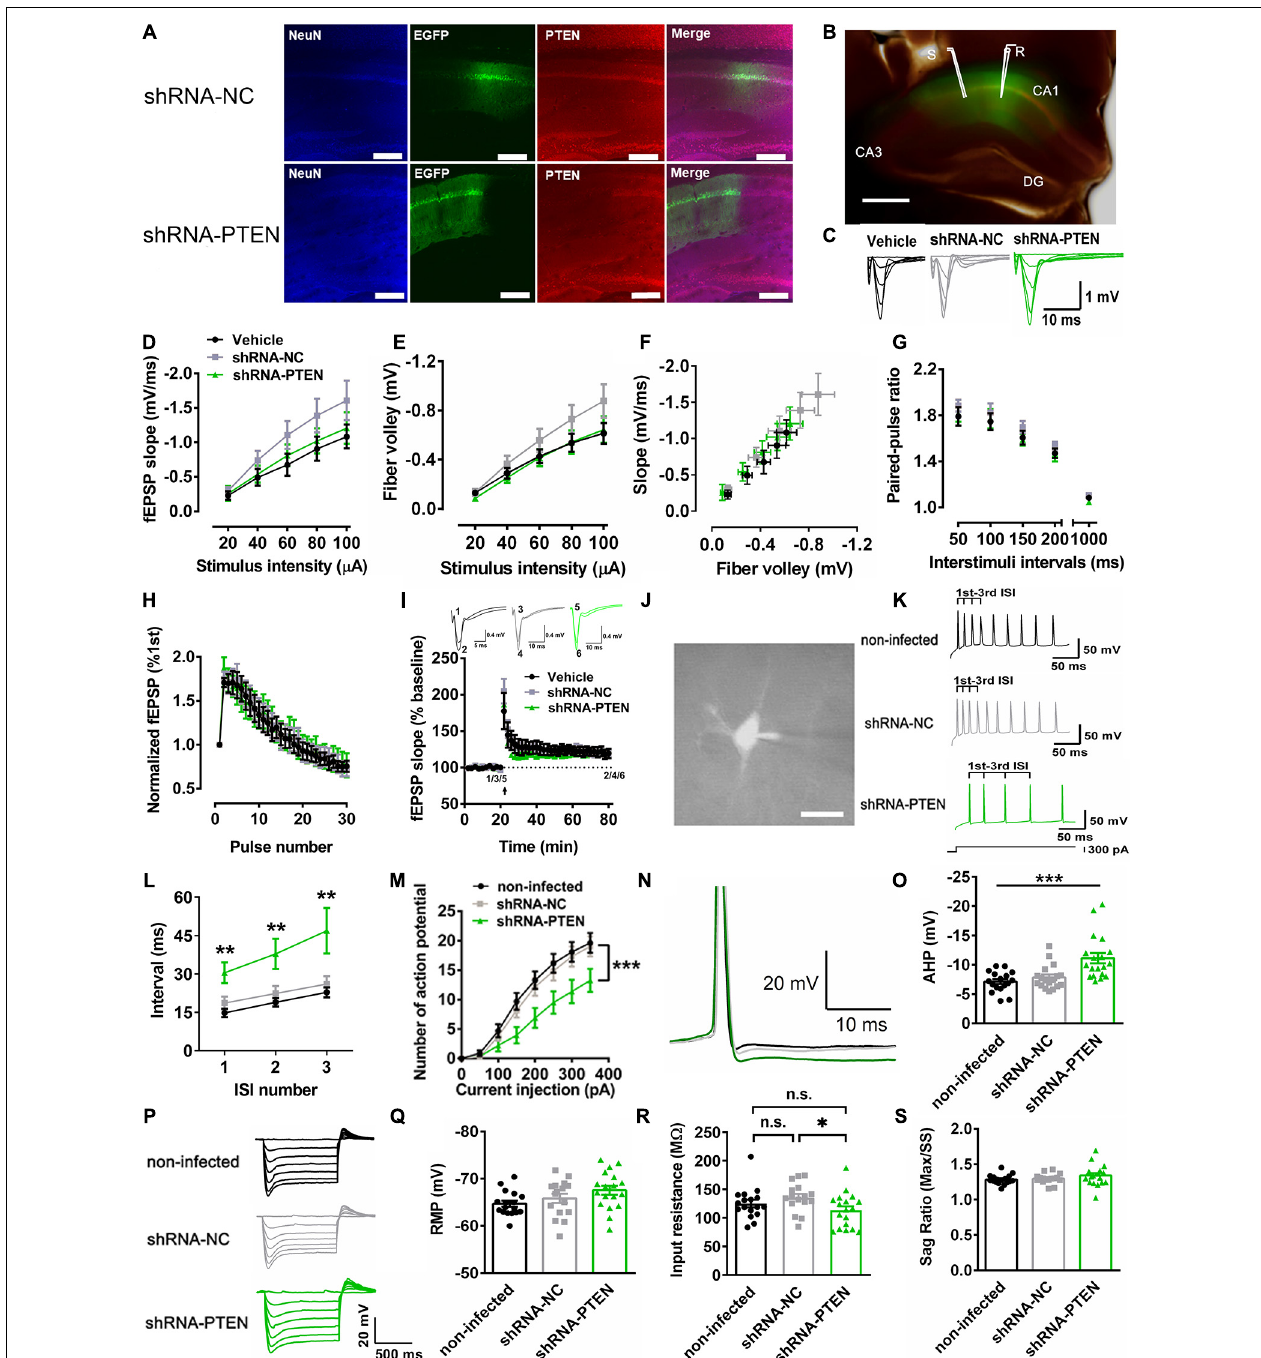
FIGURE 3 | Reduced firing rate in vitro with CA1 PTEN knock down (KD). (A) Immunofluorescence staining of NeuN and PTEN on lentivirus-infected dorsal CA1 cells labeled with EGFP. In LV-shRNA-PTEN-GFP group, cells labeled with EGFP were not labeled with anti-PTEN antibody. Calibration bar, 150 µ m. (B) Merged bright-field with EGFP fluorescence image showed representative fEPSP recording in virus-affected CA1 region of the dorsal hippocampus by stimulating the Schaffer collaterals in brain slices. Calibration bar, 500 µ m. (C) Traces for fEPSP recordings of input-output curve. (D) The input-output curve plotted with stimulus intensity against slope was not significant difference among the groups ( n = 8 from 3 mice for Vehicle, n = 7 from 3 mice for the other two groups; Two-way ANOVA with Sidak’s post hoc test. Factor of stimulus intensity x treatment, F ( 8 , 76 ) = 1.956, P = 0.0636; Factor of stimulus, F ( 4 , 76 ) = 99.92, P < 0.0001; Factor of treatment, F ( 2 , 19 ) = 1.338, P = 0.2860; P > 0.05). (E) The input-output curve plotted with stimulus intensity against fiber volley was not significant difference among the groups ( n = 8 from 3 mice for Vehicle, n = 7 from 3 mice for the other two groups; Two-way ANOVA with Sidak’s post hoc test. Factor of stimulus intensity x treatment, F ( 8 , 76 ) = 1.994, P = 0.0584; Factor of stimulus, F ( 4 , 76 ) = 124.0, P < 0.0001; Factor of treatment, F ( 2 , 19 ) = 1.326, P = 0.2890; P > 0.05). (F) The input-output curve